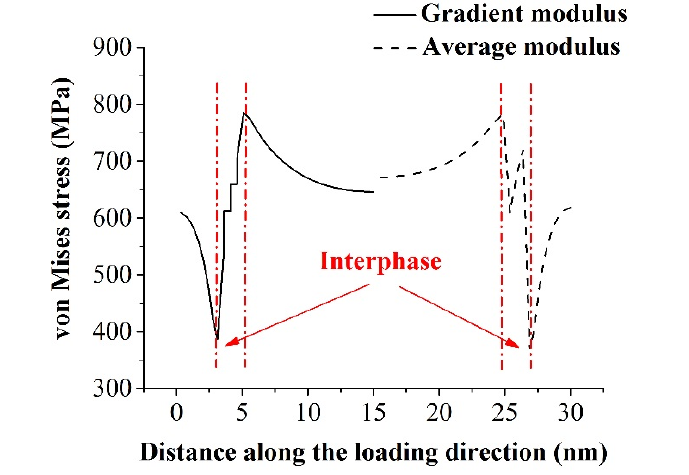
Figure 9. Von Mises stress distributions in the nanocomposites along the loading direction for the interphase with gradient modulus varied from 6 to 18 GPa or with the average modulus of 12